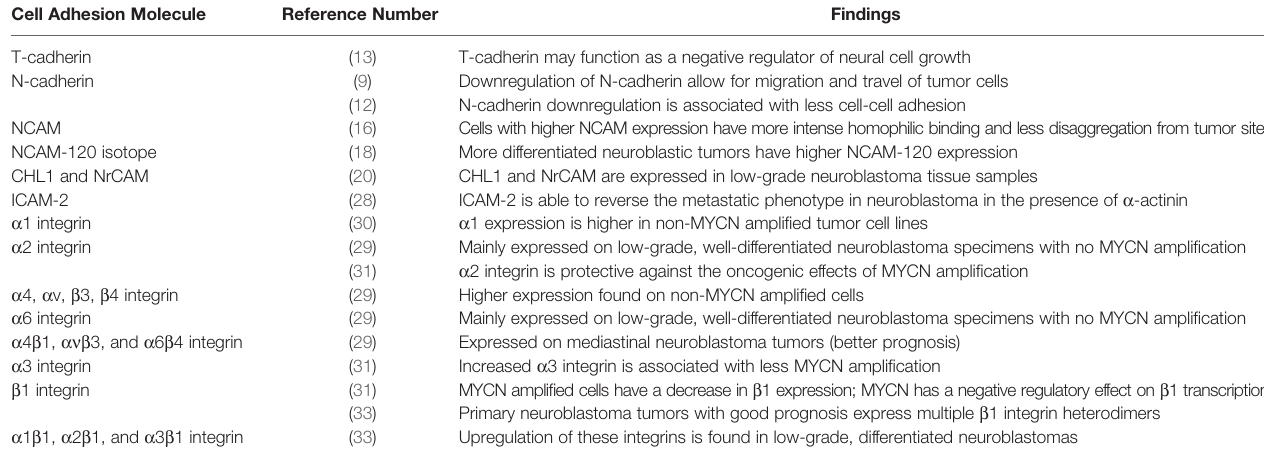
TABLE 1 | CAMs expressed in favorable neuroblastoma. Cell Adhesion Molecule